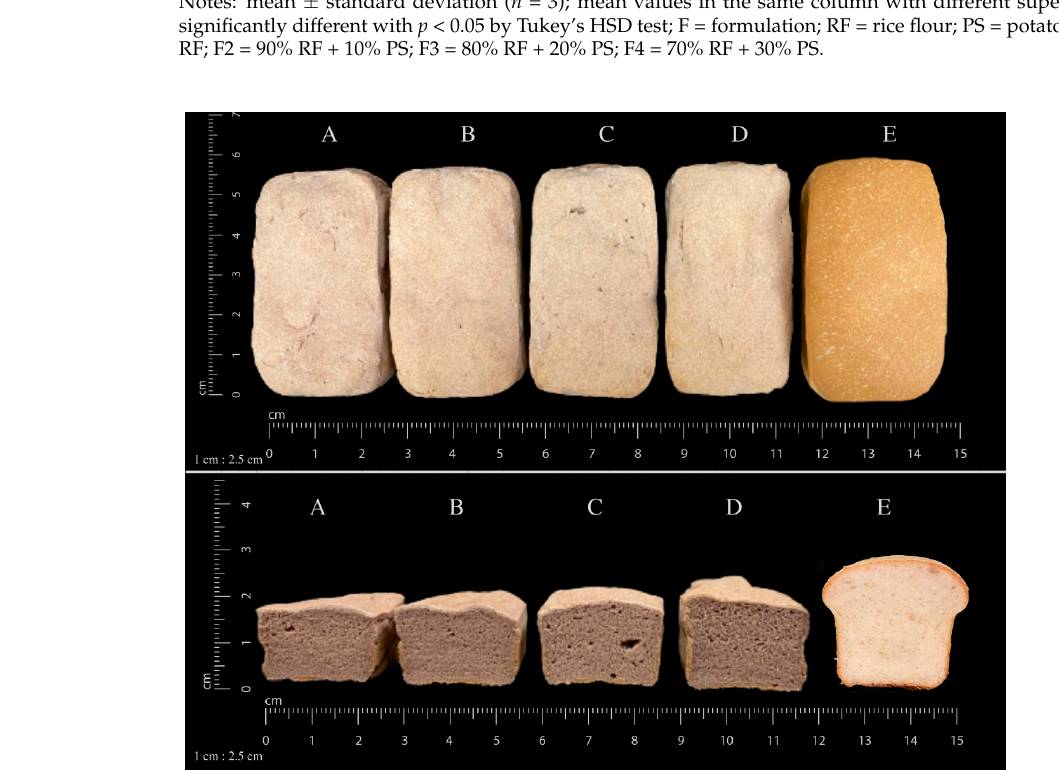
Figure 2. Gluten-free rice bread in comparison to 100% wheat bread ( E ); ( A ): F1 (100% rice flour), ( B ): F2 (90% rice flour + 10% potato starch), ( C ): F3 (80% rice flour + 20% potato starch), ( D ): (70% rice flour + 30% potato starch).